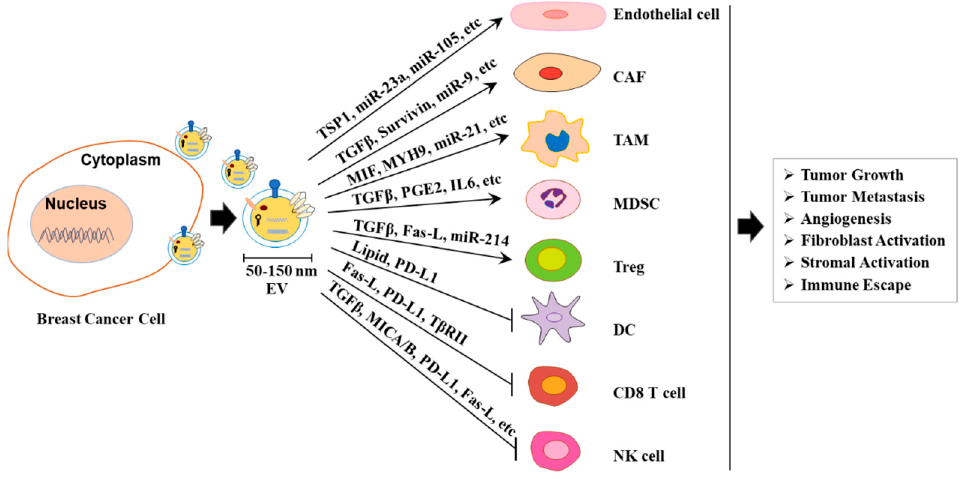
Figure 2. Schematic diagram illustrating functional pathways and target cells of BC-derived sEVs. CAF; cancer-associated fibroblasts; TAM: tumor-associated macrophage; MDSC: myeloid-derived suppressor cells; Treg: regulatory T cells; DC: dendritic cells; NK cell: natural killer cell.